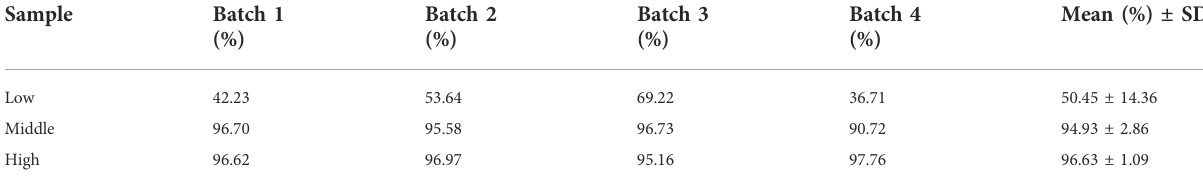
TABLE 2 Recovery of four batches of samples at 0.03, 1.25, and 2.5 μ g/mL. They were Low, Middle, and High level, respectively.